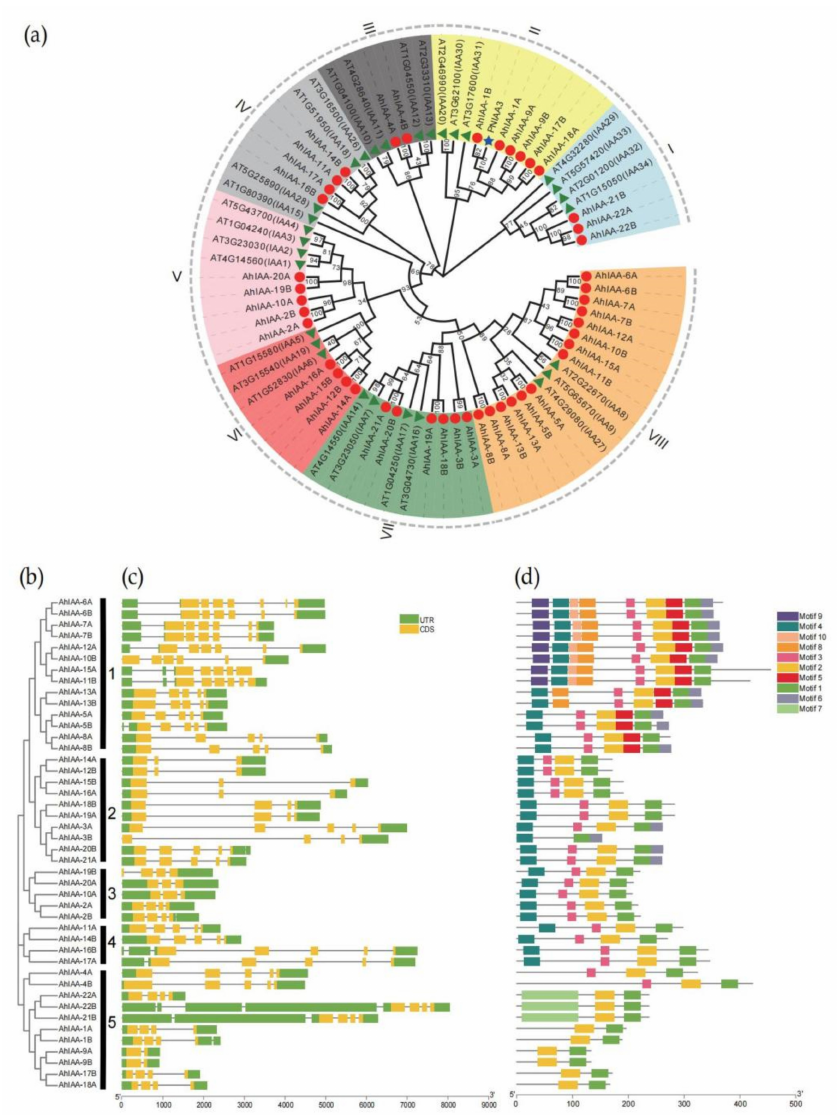
Figure 2. ( a ) Phylogenetic tree of AUX/IAA proteins from Arabidopsis and peanut. The phylogenetic tree was constructed using the Neighbor-joining (N-J) method with 1000 bootstrap replications. The eight groups were distinguished in different colors. Sequences from Arabidopsis thaliana , peanut (our study) and PNIAA3 (previous study) were labeled with red circle, green triangle and blue star, respectively. ( b ) The N-J phylogenetic tree of AhIAA proteins. Five clusters were displayed as 1 to 5. ( c ) Gene structure of peanut AhIAA genes. Green boxes indicated 5 (cid:48) and 3 (cid:48) UTR; yellow boxes indicated exons; grey lines indicated introns. The sequence length could be estimated by the bottom scale. ( d ) The motif composition of peanut AhIAA proteins. The 10 motifs were displayed in different colored boxes, and the length of proteins could be estimated by the bottom